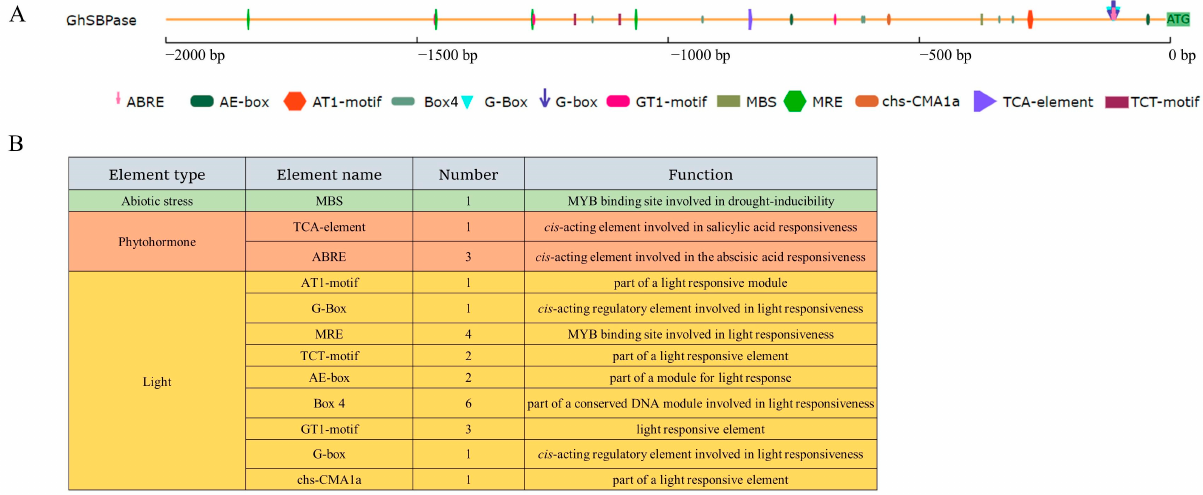
Figure 9. Cis -acting elements analysis of GhSBPase promoter in upland cotton. ( A ) The position distribution diagram of cis -acting elements in GhSBPase promoter, and different colors represent different kinds of cis -acting elements. ( B ) Category and number of cis -acting elements in GhSBPase promoter.